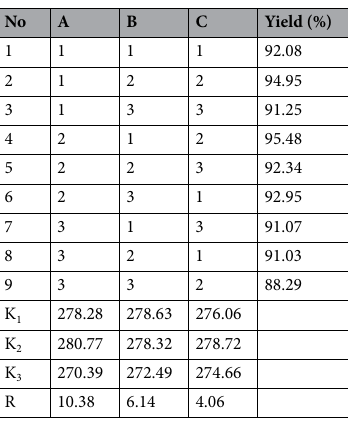
Table 2. Results and analysis of designed orthogonal